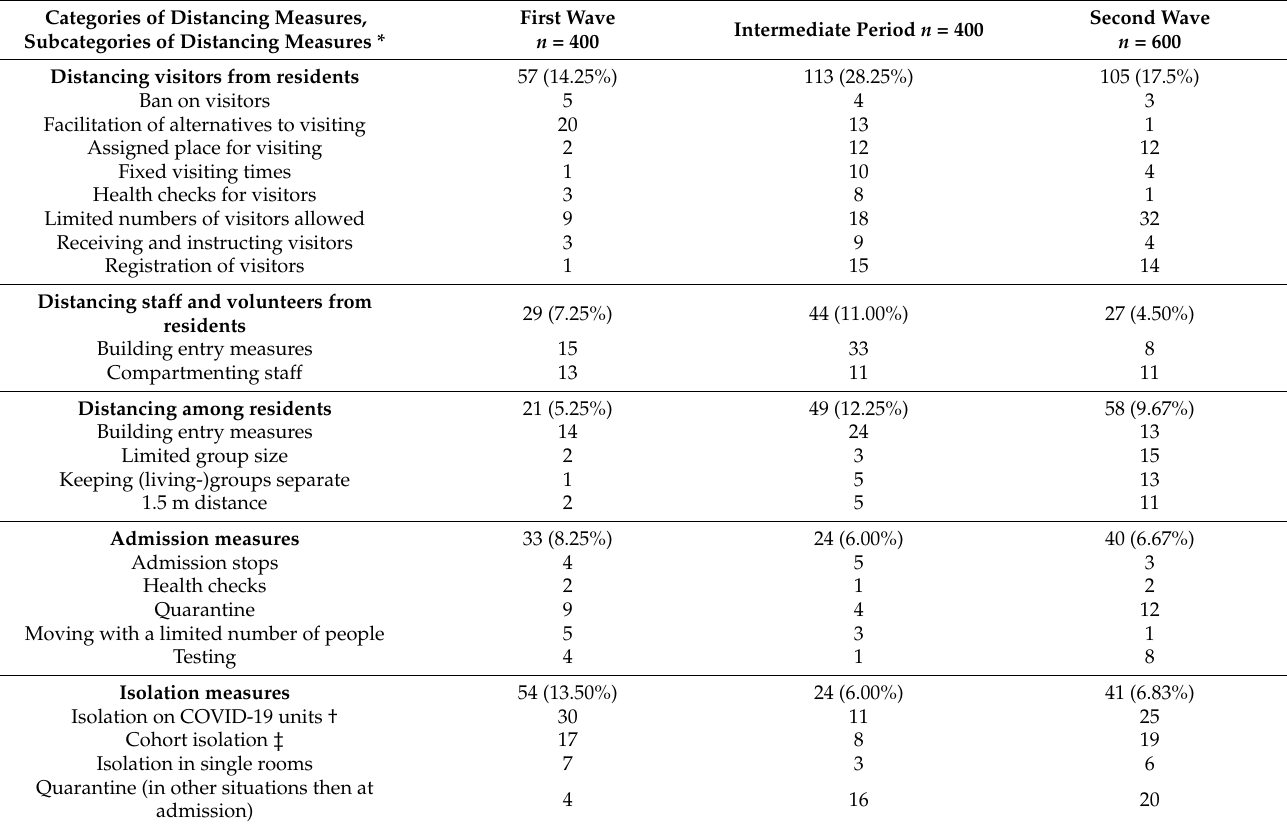
Table 1. Textual units per category of distancing measures discussed by COVID-19 outbreak